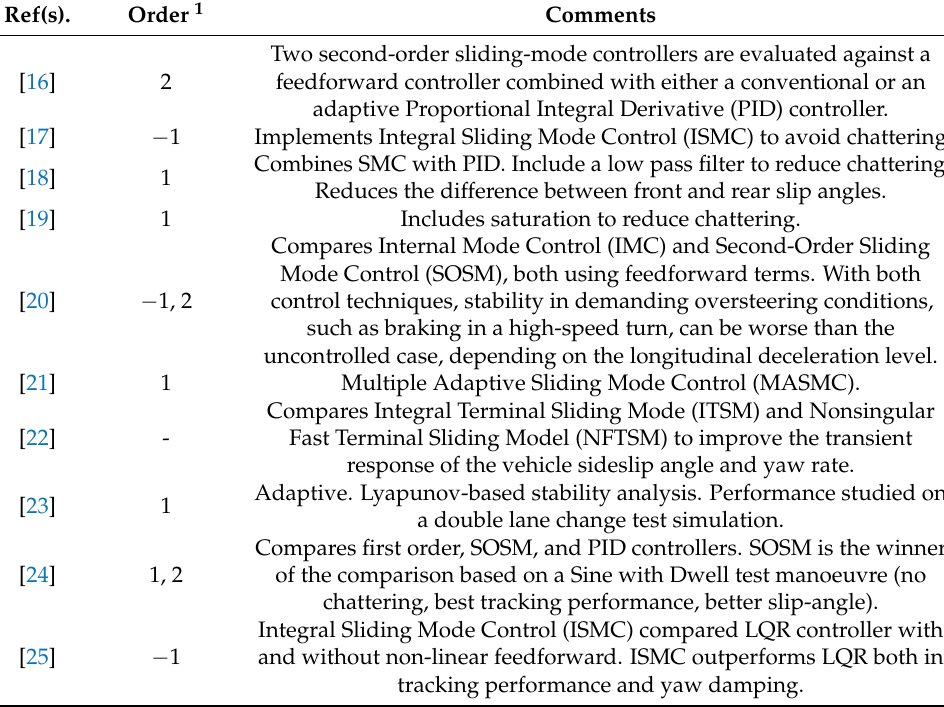
Table 2. Sliding Mode Control (SMC) controllers in the literature on DYC. Ref(s).